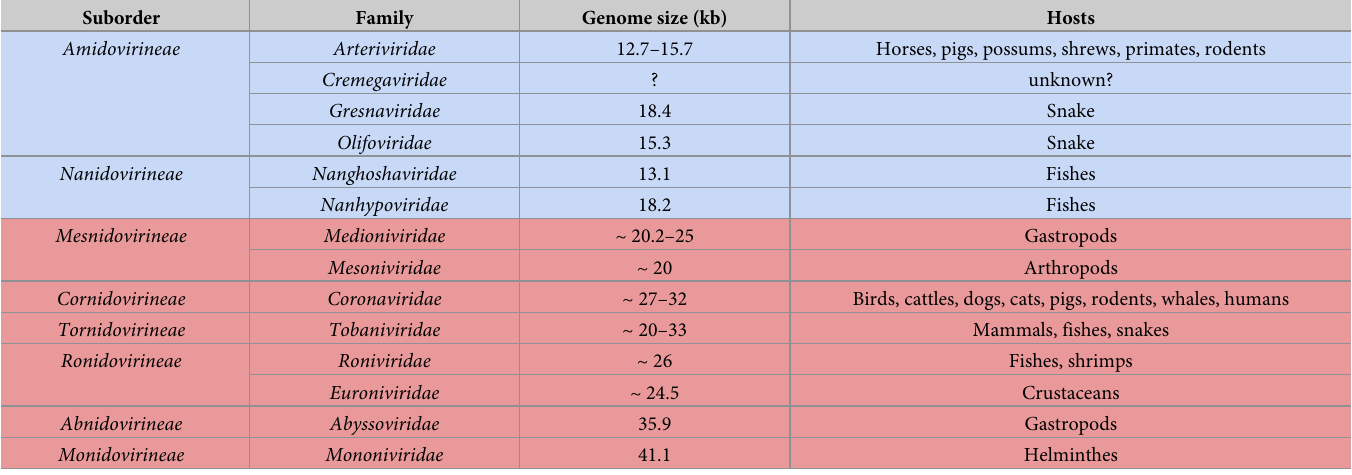
Table 1. Viral families belonging to Nidovirales